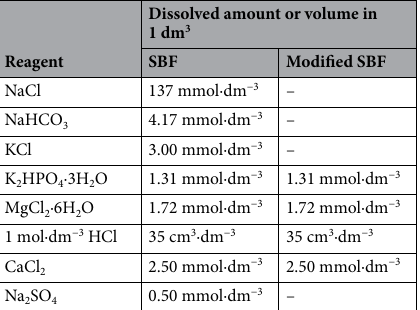
Table 1. Amounts of dissolved reagent in the preparation of 1 dm 3 SBF and modified-SBF.